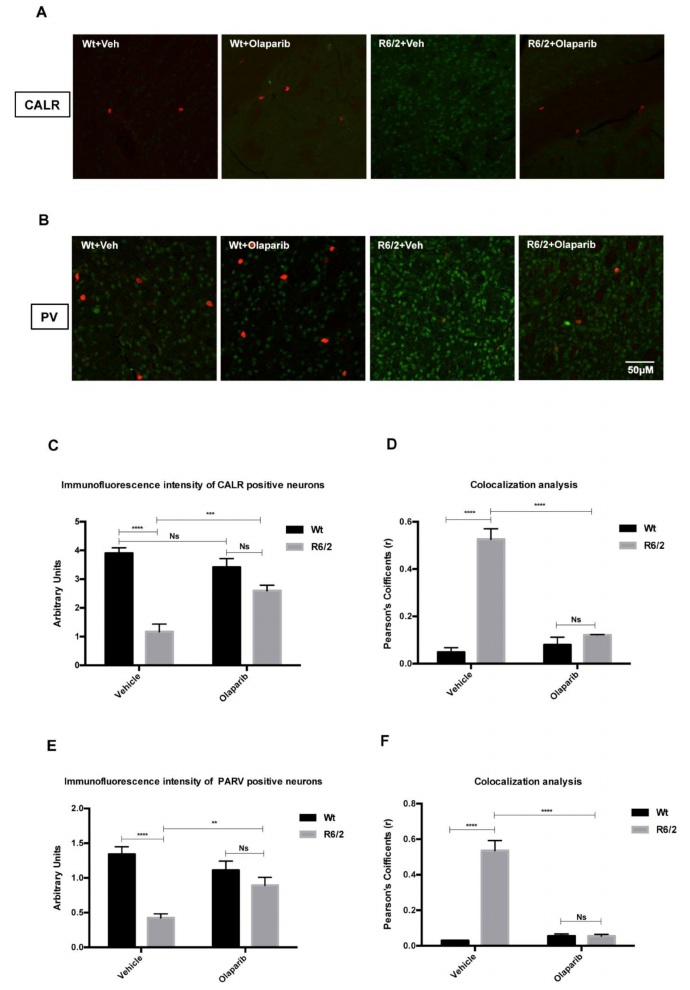
Figure 5. Olaparib prevents Parvalbuminergic and Calretininergic neurons loss. ( A , B ) Bonferroni analysis showed the significant dramatical reduction of number and immunofluorescence intensity of Calretinin and Parvalbumin containing neurons in the striatum of 13-week-old R6 / 2 mice compared to that of vehicle or Olaparib-treated Wt mice ( C – E ). ( F , G ) Graph shows no colocalization of NLRP3 in PARV and CALR interneurons of animal groups treated with Olaparib (mean Pearson’s coe ffi cients equal to zero) and the statistically significant colocalization of NLRP3 in Parvalbumin and Calretinin containing interneurons ( p < 0,001) of vehicle R6 / 2